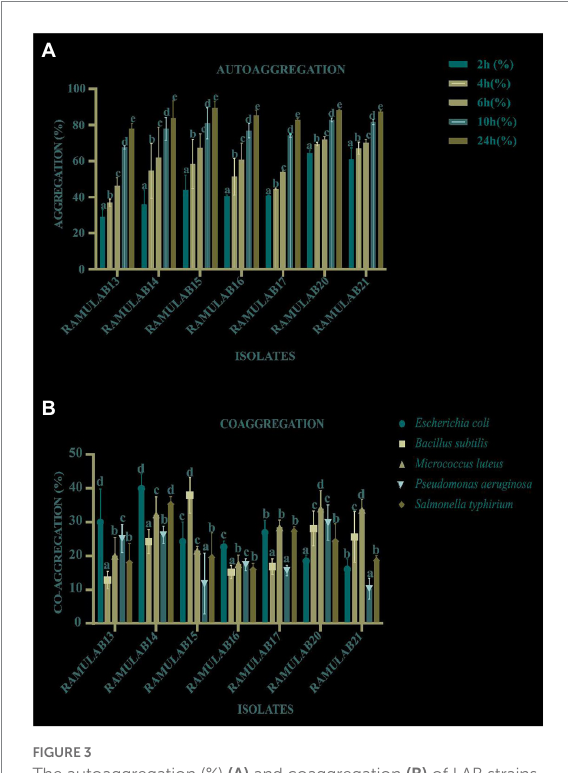
FIGURE 4 Under a light microscope, the adherence of LAB strains to chicken crop epithelial cells, The adhesion of isolates: (A) RAMULAB13, (B) RAMULAB14, (C) RAMULAB15, (D) RAMULAB16, (E) RAMULAB17, (F) RAMULAB20, (G) RAMULAB21 to chicken crop epithelial cells. LAB strains are seen adhering to the epithelial cells as indicated by the black